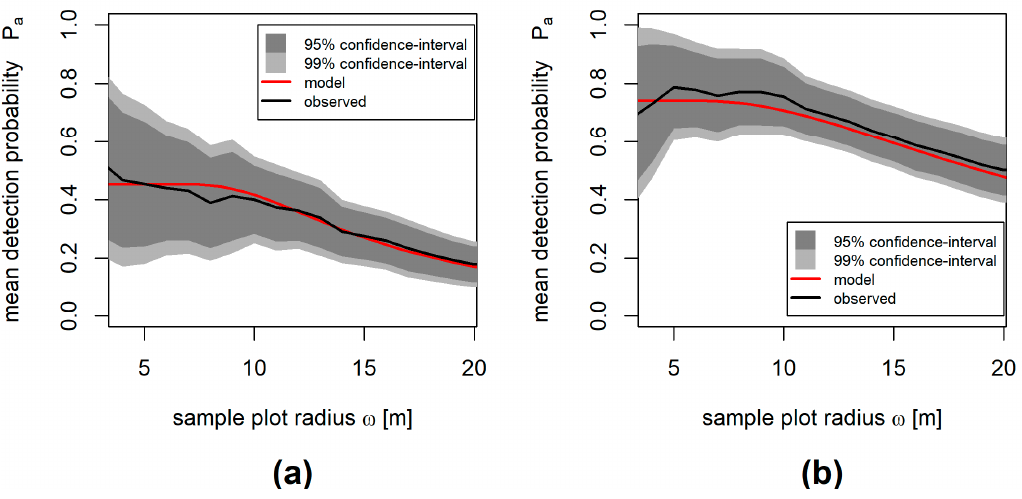
Figure 4. Mean detection probability P a for di ff erent sample plot radii ω using TLS in single-scan mode for both strata. The black line represents the observed data; the red line represents the model prediction. The light and dark grey areas are the 99% and 95% confidence intervals computed from the observed data, respectively. ( a ) Small trees (5 cm ≤ dbh < 20 cm) and ( b ) large trees (dbh ≥ 20 cm).